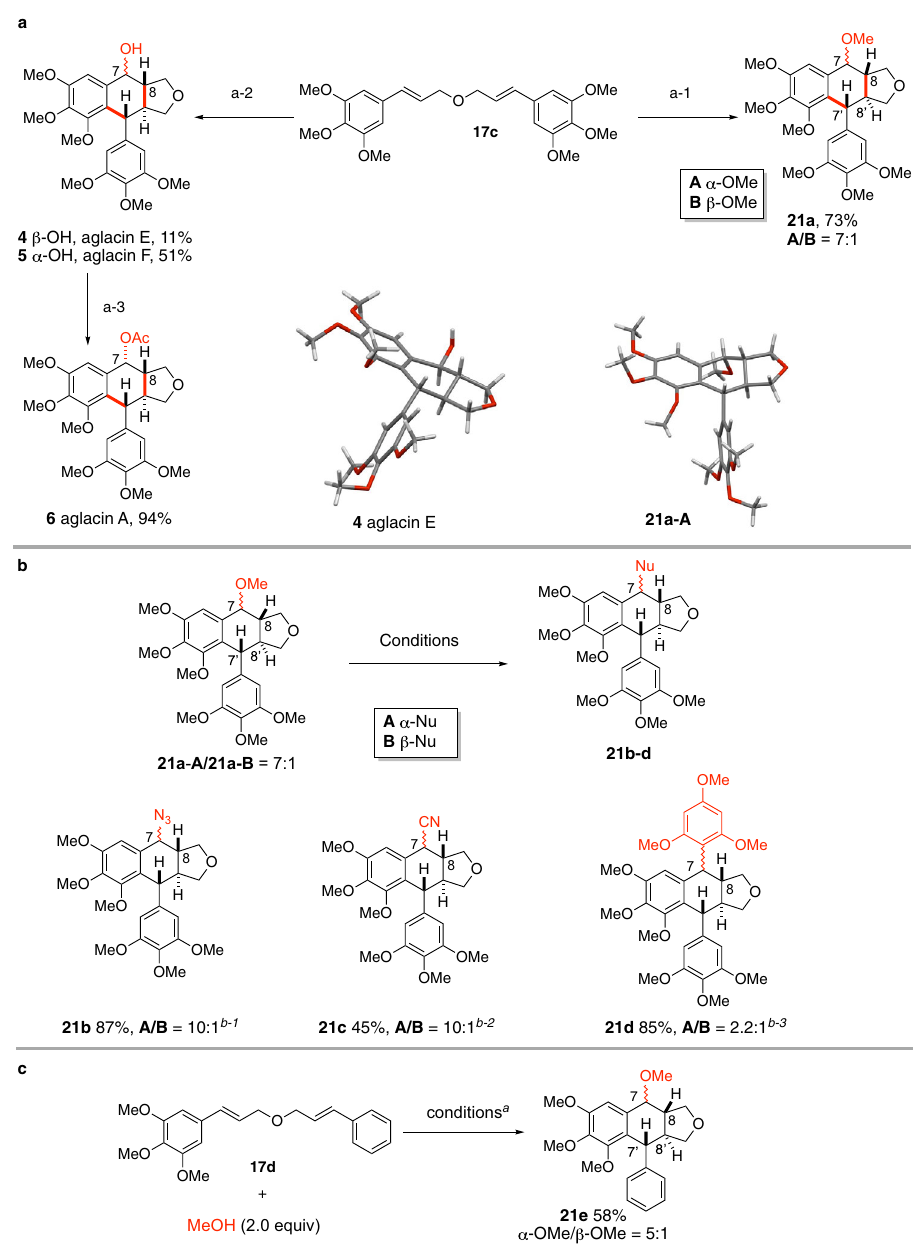
Fig. 4 Synthesis of C7-functionalized aryltetralin cyclic ethers. a Total synthesis of aglacin E ( 4 ), F ( 5 ) and A ( 6 ). Reagents and conditions: a-1) MeOH (2.0 equiv), [Mes-Acr-Me] + BF 4 − (5 mol%), Cu(TFA) 2 (cid:129) x H 2 O (1.2 equiv), DCM, N 2 , RT, Blue LED; a-2) AcOH (2.0 equiv), [Mes-Acr-Me] + BF 4 − (5 mol%), Cu(TFA) 2 (1.2 equiv), DCM, N 2 , RT, Blue LED, aqueous work-up; a-3) Ac 2 O, 1 H -imidazole (1.2 equiv), DMAP (0.4 equiv), DCM, RT; b Synthesis of natural product analogs. Reagents and conditions: b-1) TMSN 3 (1.5 equiv), TBSOTf (0.2 equiv), DCM, RT, 1 h; b-2) TMSCN (1.5 equiv), Sc(OTf) 3 (0.2 equiv), DCM, RT, 12 h; b-3) 1,3,5-trimethoxybenzene (1.5 equiv), TBSOTf (0.2 equiv), DCM, RT, 1 h; c Cyclization of unsymmetric diallyl ether 17d . Reagents and conditions: 17d (0.1 mmol), [Mes-Acr-Me] + BF 4 − ( 16 ) (5 mol%), Cu(TFA) 2 (0.12 mmol, 1.2 equiv), DCM (4.0 mL, c 0.025 M), 24 W blue LED, 23 °C.